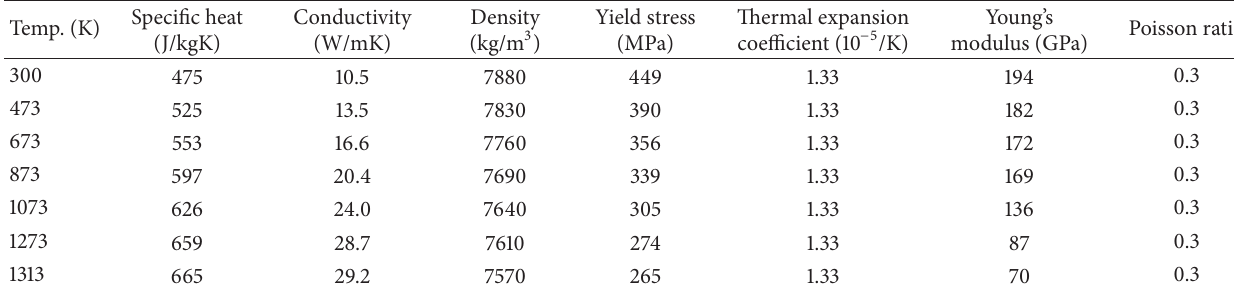
Table 2: Temperature-dependent material properties of